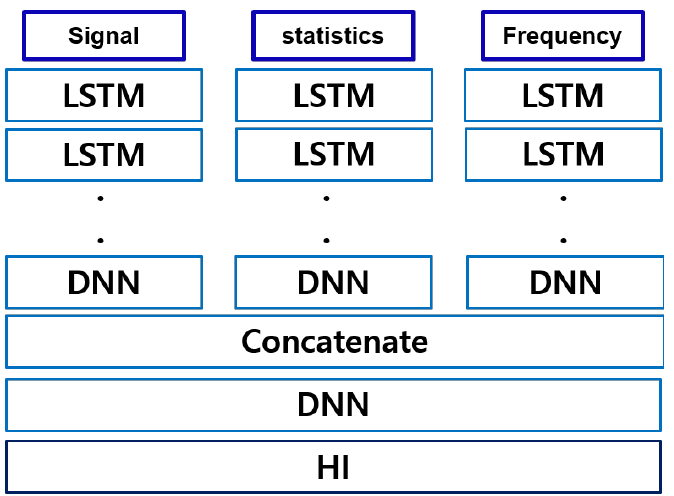
Figure 15. Network models of one-stage FEAE and